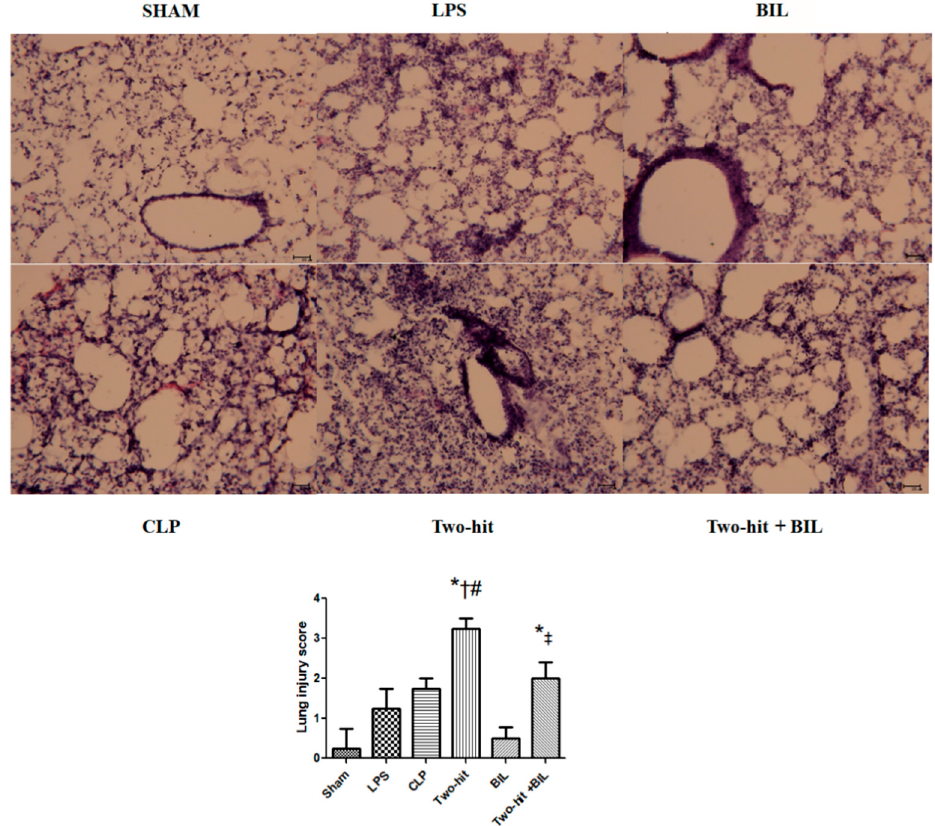
Figure 6. Lung tissue histology. Mice were administered i.p. LPS at 5 mg / kg body weight on day 0. After 24 h, the mice were challenged with cecal ligation and puncture (CLP: 25-gauge needle and double-puncture). Next, the mice were administered bilirubin at 30 mg/kg body weight. Histopathologic examination (H&E staining, original magnification X200) of the lung was performed after one day. The degree of lung injury was identified as described in the material and method part. # p < 0.05 versus LPS. † p < 0.05 versus CLP. ‡ p < 0.05 versus “two-hit”.